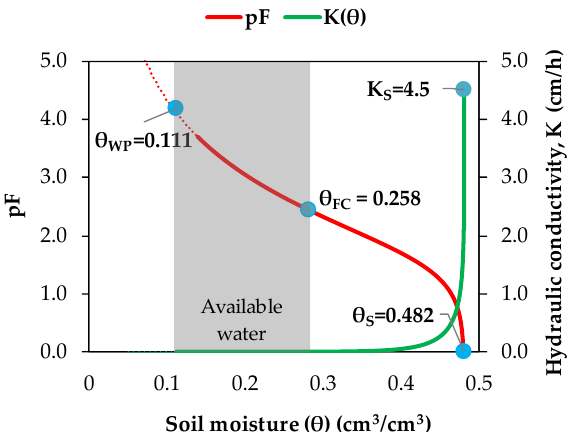
Figure 3. Soil moisture relation curves against pressure head, h (red line), and hydraulic conductivity, K (green line), as derived from laboratory results and RETC software. Shaded area depicts the soil layer that includes available water for the plants. The continuous red line indicates the fitted pF curve produced by using measured retention data for pressures up to 5 bars, whereas the dashed red line is constructed after extrapolation and refers to higher pressures ( θ WP was estimated for 15 bars pressure).